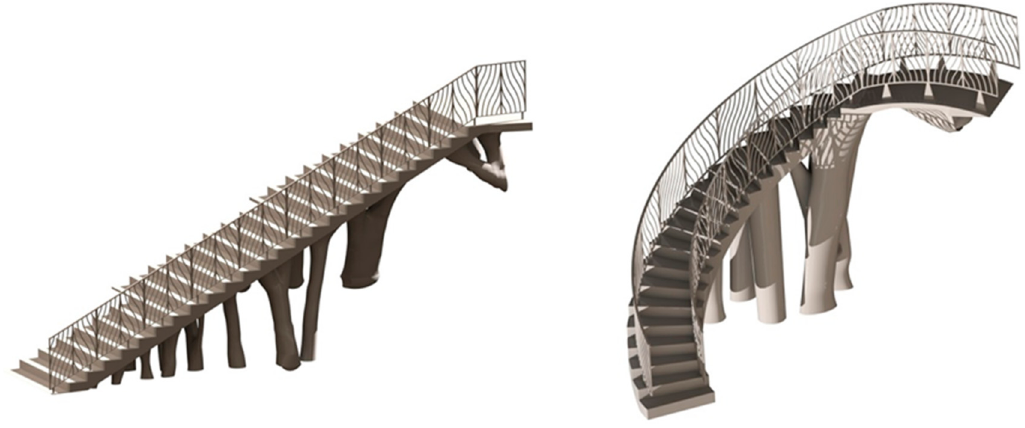
Figure 29. Geometrical models of the construction elements under study, imported into the BIM environment E 1 ( left ) and E 2 ( right environment E 1 ( left ) and E 2 ( right ). Table 10. Group set used to define the catalog or Datagroup of the constructive BIM elements E 1 and E 2 .